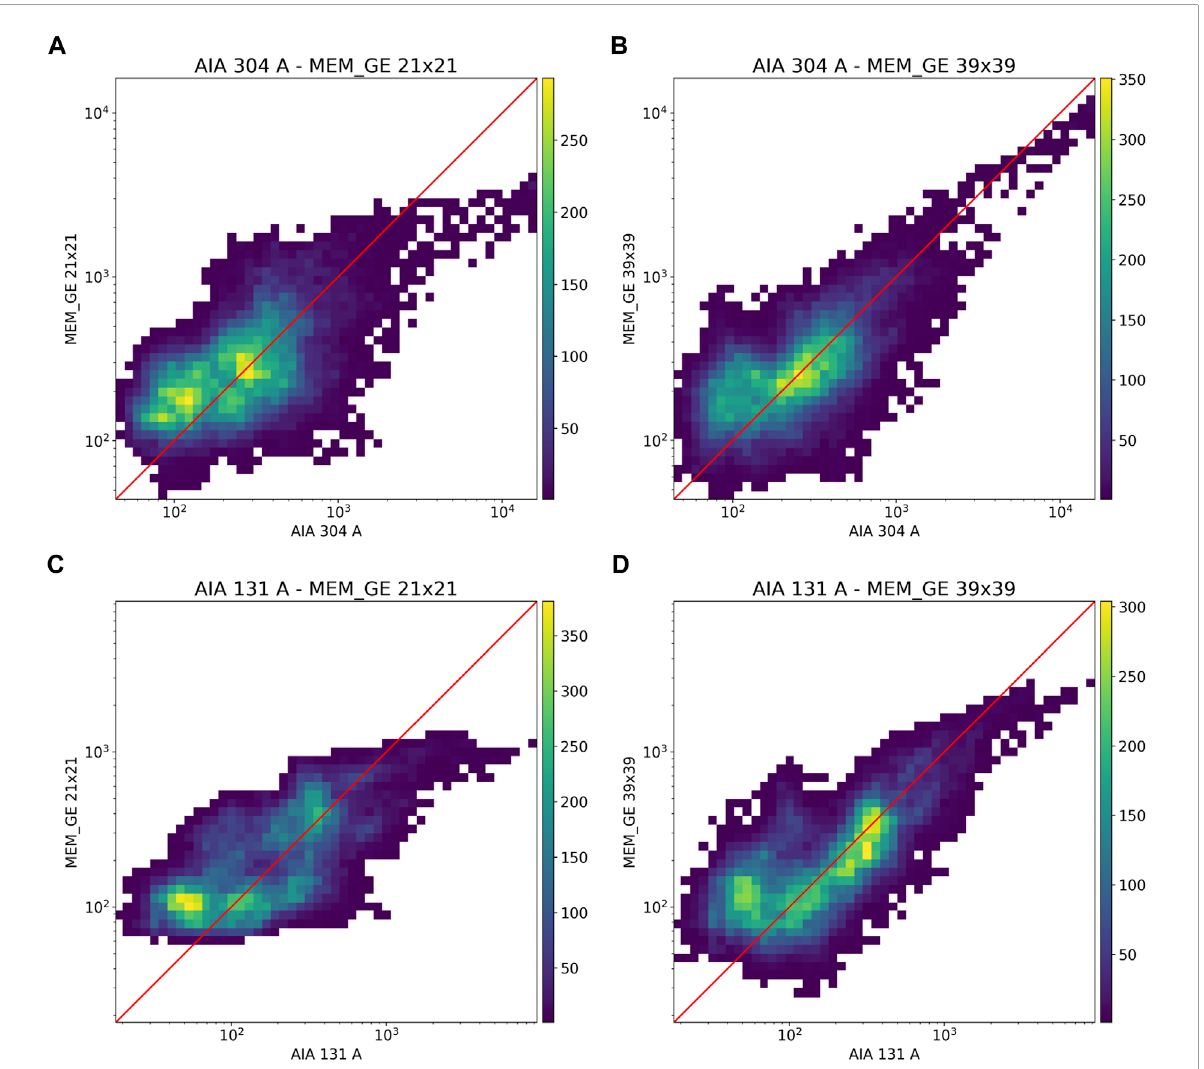
FIGURE 7 Histograms of the pixel values of the MEM_GE reconstructions, shown in Figure 6 , plotted (vertical axes) versus the corresponding pixel values in the AIA maps (horizontal axes). Both the x - and y -axes have been binned in logarithmic steps and the color map refers to the number of points falling within each bin. Panels (A) and (B) show the histograms of the MEM_GE reconstructions of the AIA 304 Å image from 21 × 21 and from 39 × 39 visibilities, respectively. Panels (C) and (D) show the same information, but for the AIA 131 Å image. In each panel, a logarithmic scaling is applied to both the x - and y -axes and a red line representing equality is plotted as a